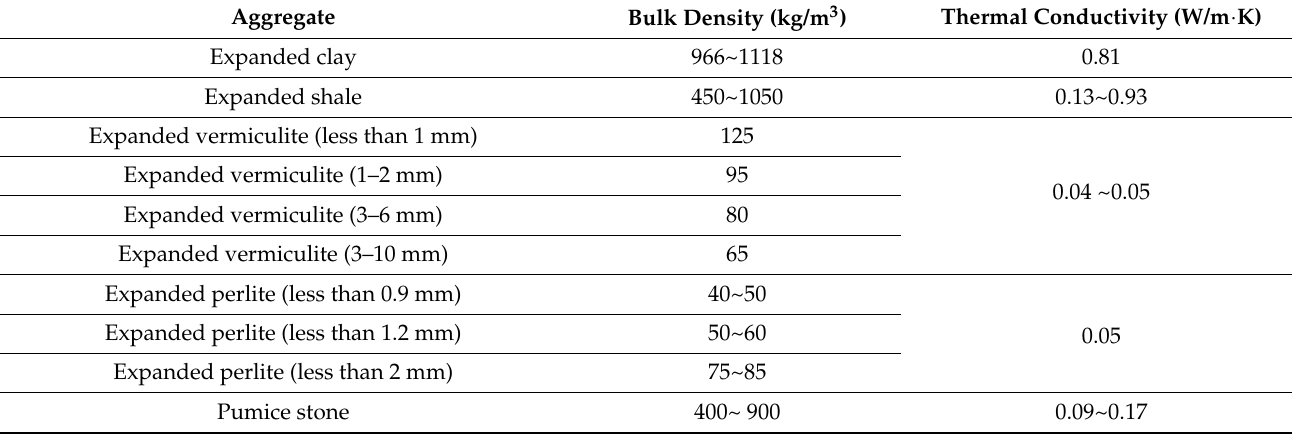
Table 4. Characteristics of lightweight aggregates